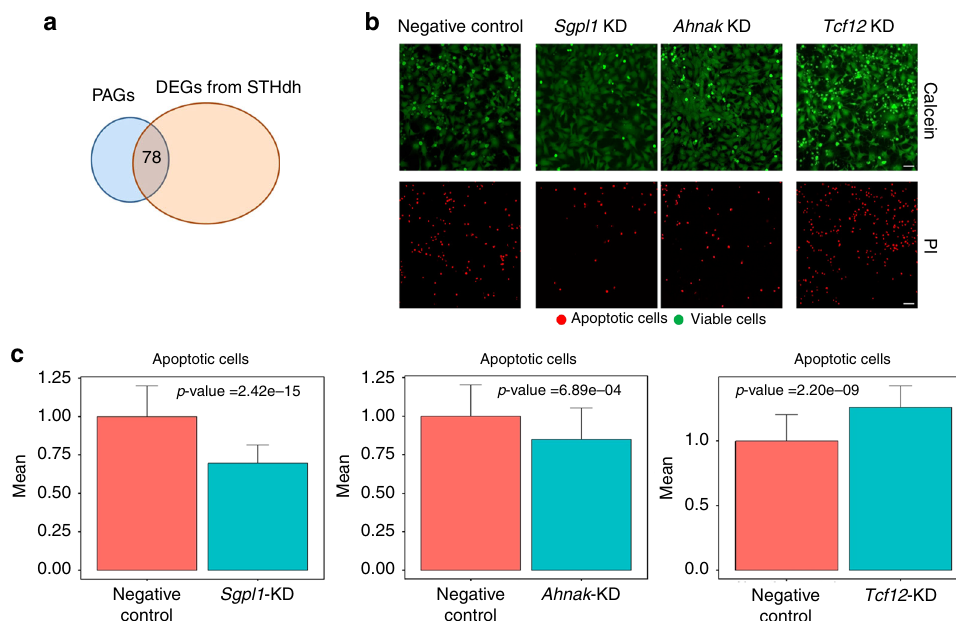
Fig. 3 High-ranked upregulated PAGs are modi fi ers of cellular viability. a 78 overlapping genes were identi fi ed between human PAGs and STHdh DEGs. b Knocking-down high-ranked upregulated genes signi fi cantly alters apoptosis in STHdh Q111 cells compared to cells transfected with negative control siRNA. Calcein ( green ) stains viable cells, while propidium iodide (PI — red ) is a marker for late apoptotic cells. Scale bar = 10 μ m. c The number of apoptotic cells is represented as fold changes normalized to the control. Two-tailed t -test was performed to calculate statistical signi fi cance. The bar shows the mean value and the error bars indicate the standard deviation. Three independent experiments were performed, with 15 replicates